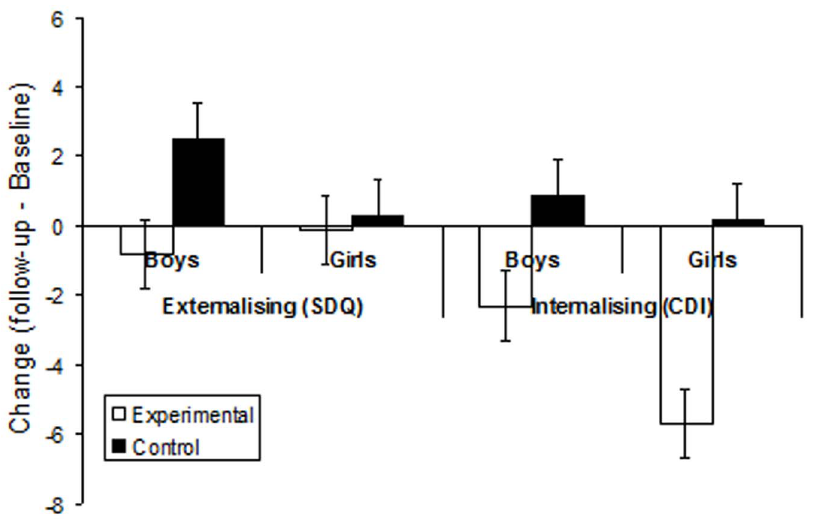
Figure 3. Mean in change (follow-up minus baseline) in externalising (SDQ) and internalising (CDI) scores for the two groups (experimental = computer-based programme; control = normal reading classes) for both boys and